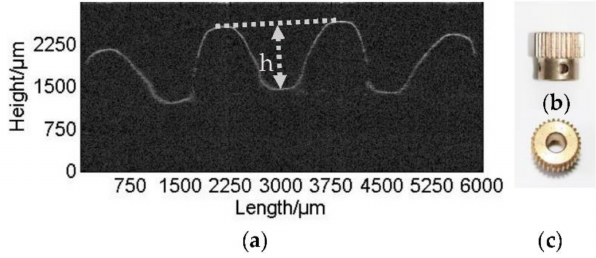
Figure 3. OCT image of a small-module metal copper gear. ( a ) OCT image of a copper gear; ( b ) the right view of the copper gear; ( c ) the top view of the copper